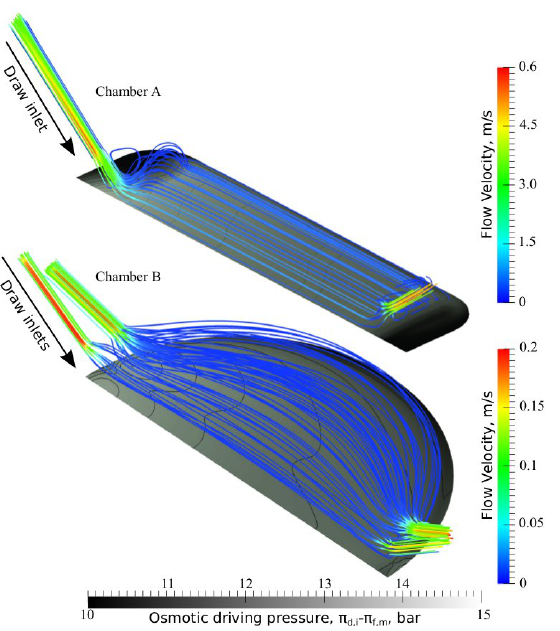
Figure 8. Velocity streamlines traced from the inlets of draw solution compartments in chambers A and B. The velocity streamlines are colored according to the magnitude of the velocity field (scale on right), and the membrane plane is colored according to the effective osmotic driving pressure across the membrane (bottom